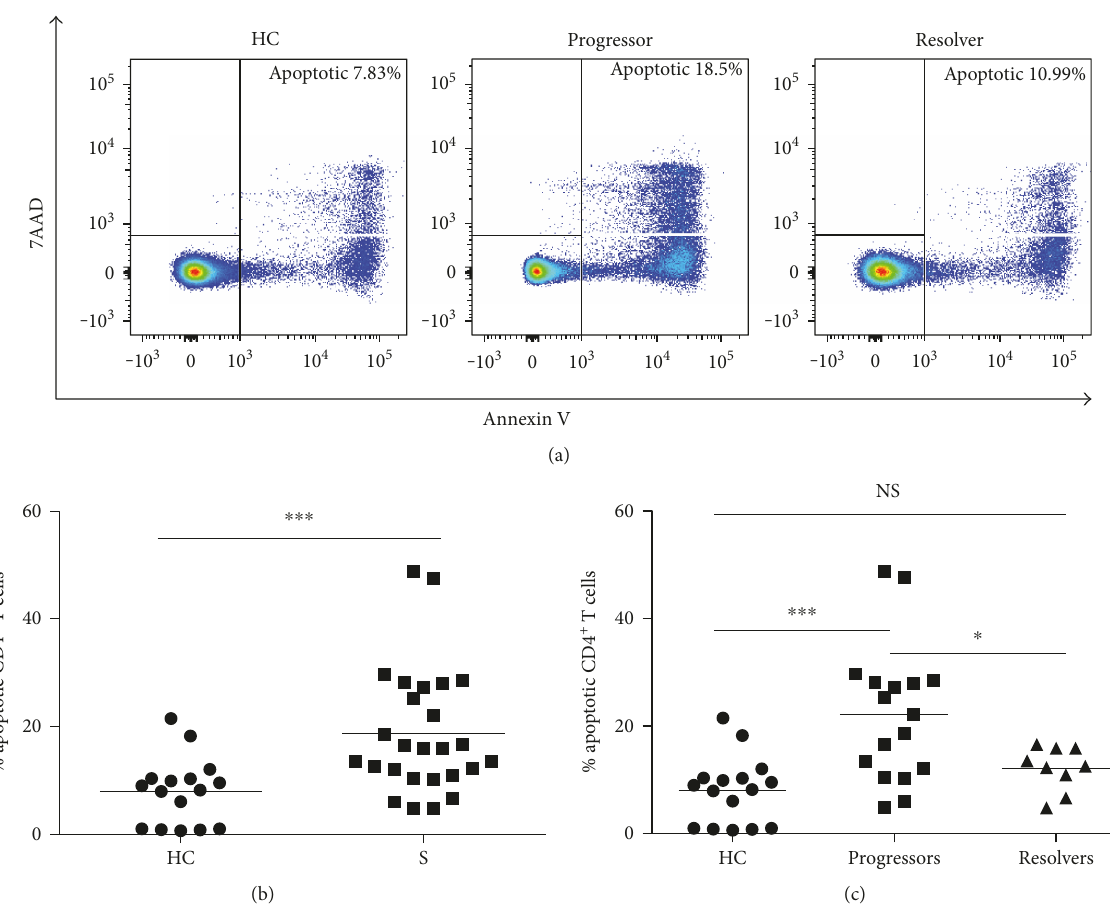
Figure 3: Increased spontaneous apoptosis in sarcoidosis CD4 + T cells. CD4 + T cells were sorted from healthy control (HC) and sarcoidosis (S) PBMC and stained at baseline with apoptosis biomarkers, Annexin V and 7AAD. Flow cytometry was conducted, and FlowJo software was used to gate on apoptotic cells. (a) Representative fl ow cytometry histograms illustrating the gating strategy used to determine the population of apoptotic cells. (b) Plot of healthy control and sarcoidosis apoptosing CD4 + T cells. Statistical analysis was performed using the Mann – Whitney U test. (c) Plot of healthy control versus sarcoidosis progressor and resolver apoptosing CD4 + T cells. Statistical analysis was performed using one-way ANOVA with Tukey ’ s HSD. Horizontal lines represent mean percentages of apoptosing CD4 + T cells. ∗ p < 0 05 and ∗∗∗ p < 0 001 . NS: not signi fi